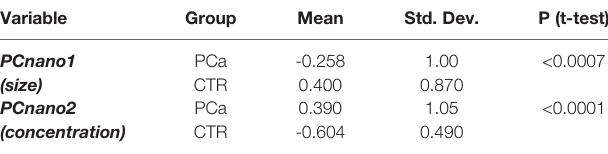
TABLE 4 | Pearson correlation coef fi cients between PCnano1, PCnano2 and NSFC